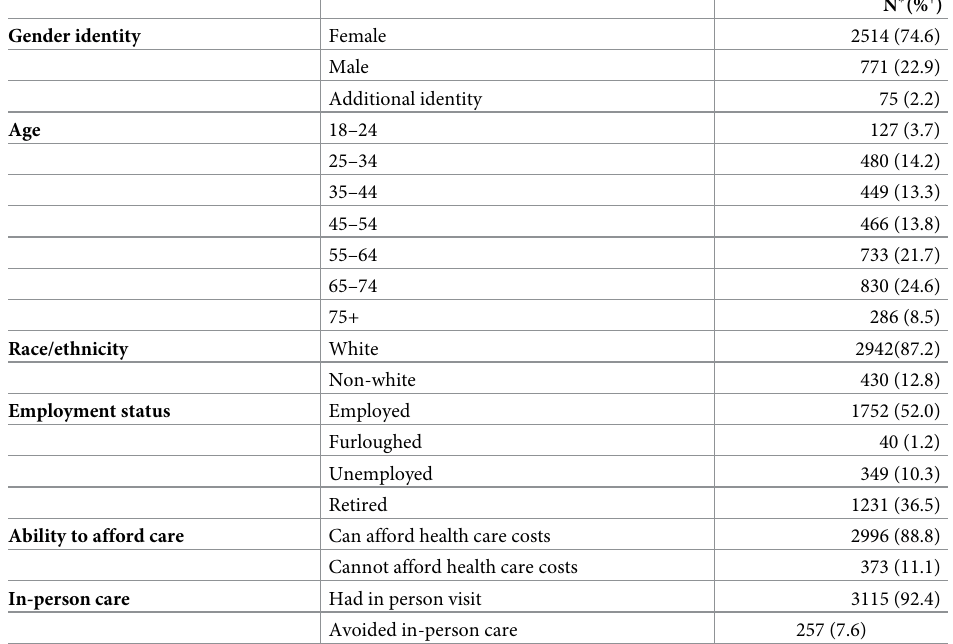
Table 1. Demographics of study participants (n =